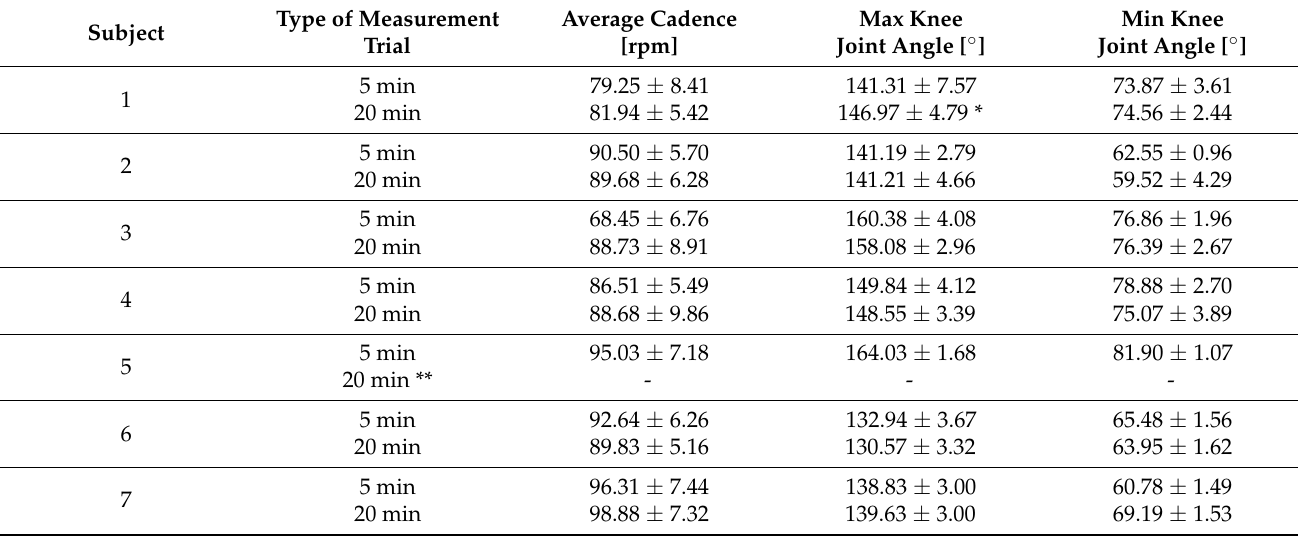
Table 2. Knee joint angle average root mean square errors ( RMSE ) by crank cycle with an interval of ± two standard deviations for the entire measurement trial and the last 10 cycles. The average RMSE for each method is presented at the end of the table.